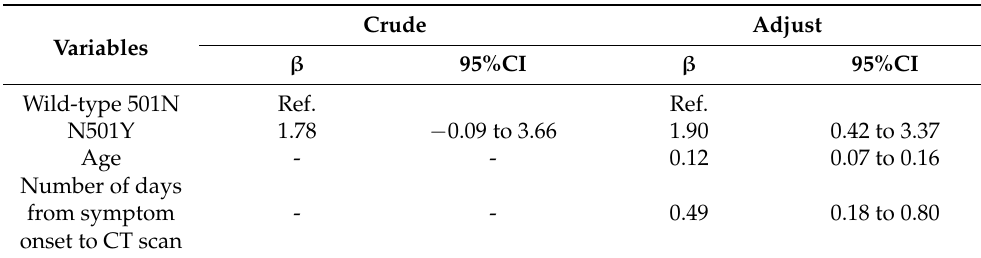
Table 5. The associations of CT score with N501YV infection, using univariable and multivariable linear regression models. ( n = 51